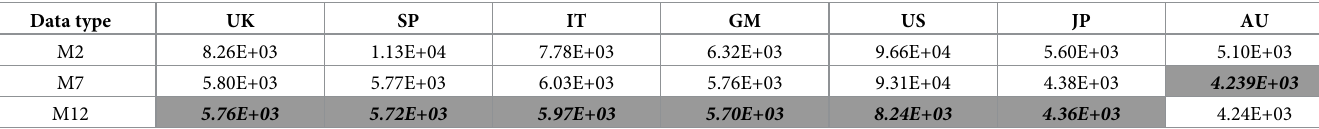
Table 7. DIC (Eq 11) for Model 2, Model 7 and Model 12 in the pre- and post-vaccine period (January 2020—January 2021). Data